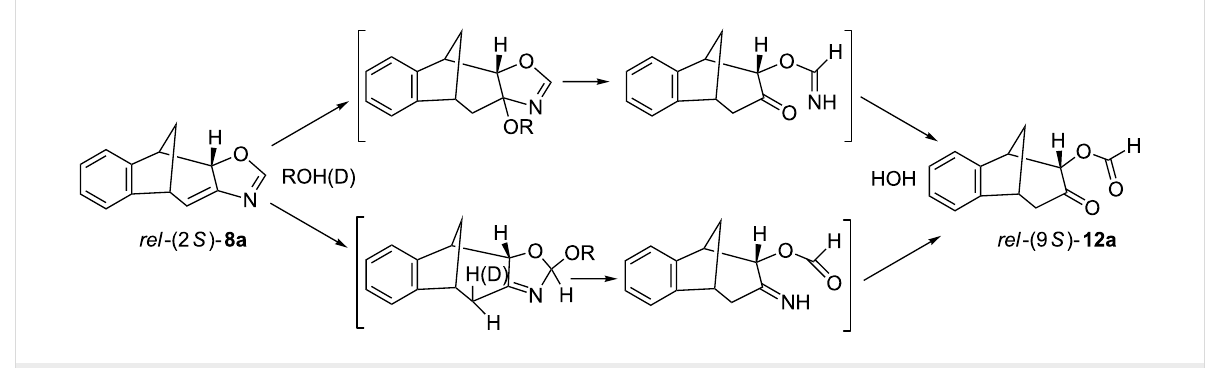
Scheme 6: Plausible mechanisms of oxazoline ring opening in photoproduct 10 and formation of 12